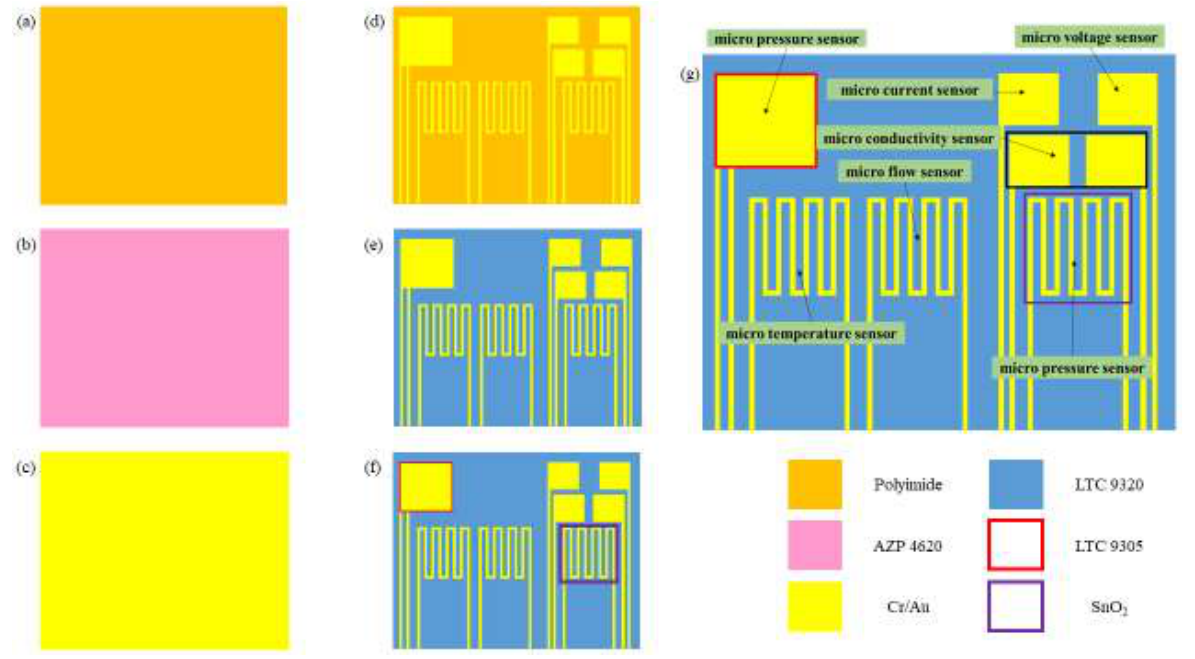
Figure 1. Process diagram of flexible 7-in-1 microsensor .